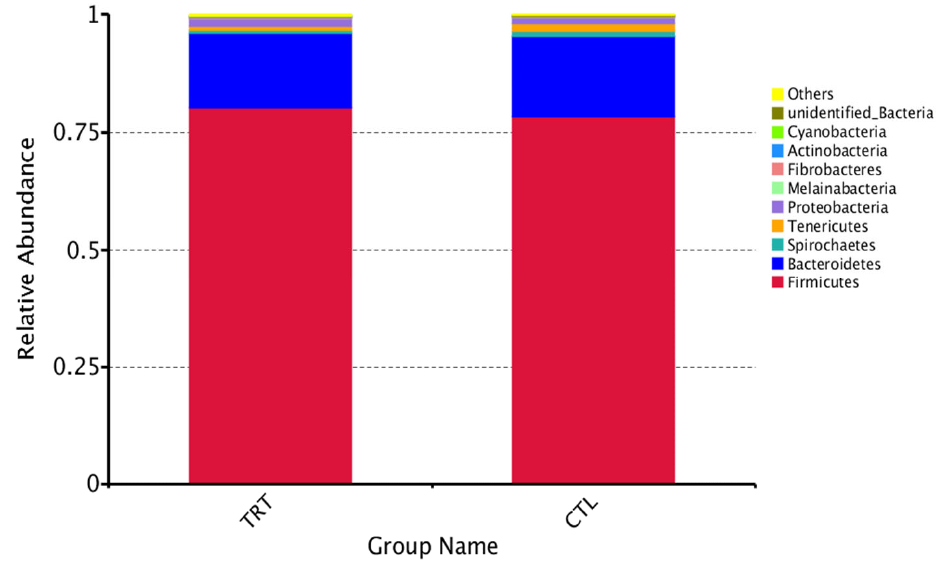
Figure 4. 16S rRNA gene analysis revealed phylum-level differences in lactation sow feces between treatments. n = 10. CTL, sow fed the basal diet; TRT, sow fed basal diet with silymarin 40 g/d from late gestation to lactation.